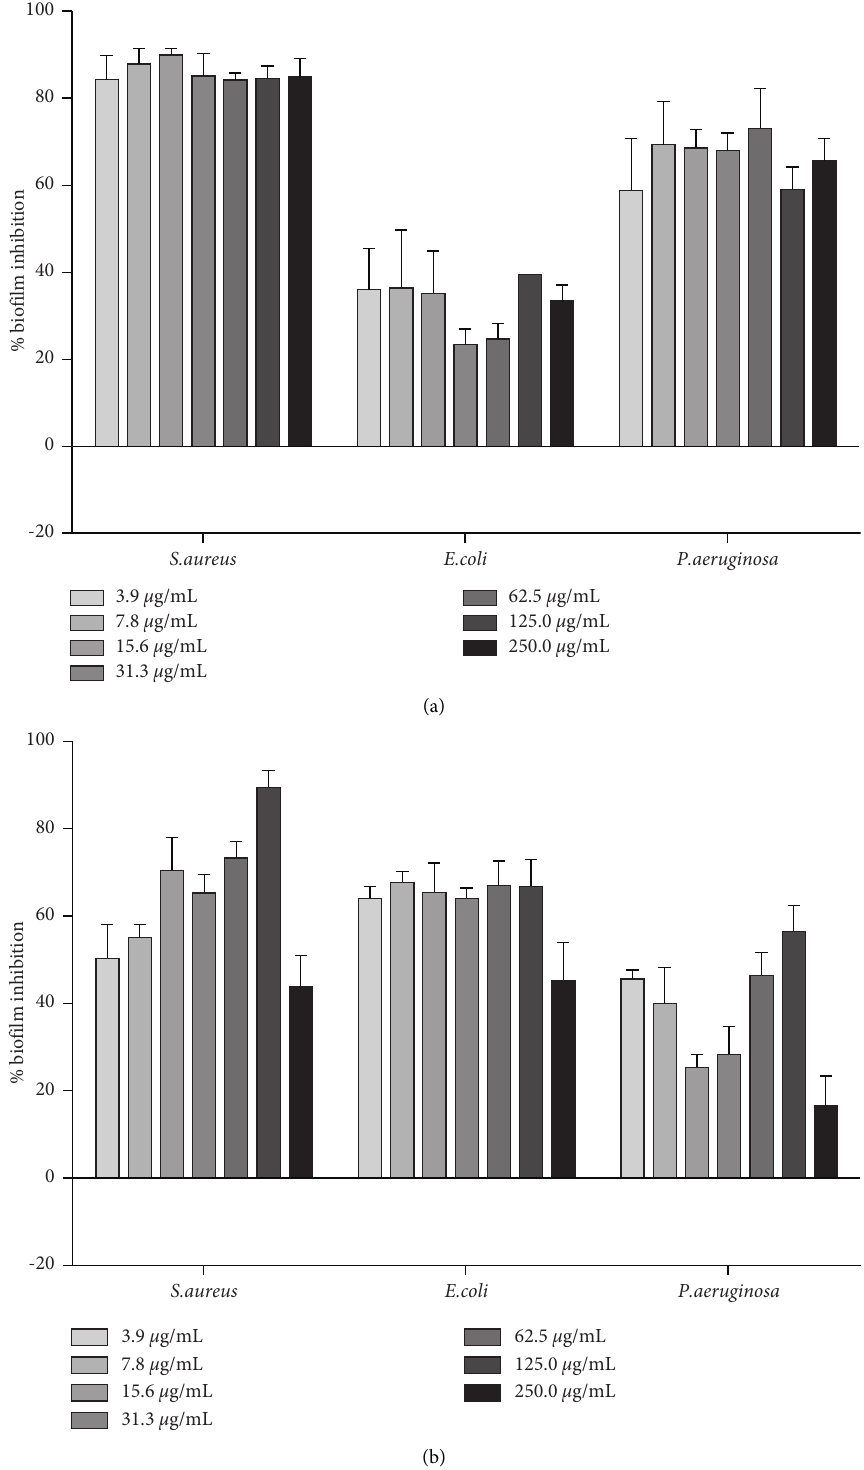
Figure 2: Antibiofilm formation activity of the EtOAc fraction, AEF (a), and the pet-ether fraction, APF (b), in S. aureus, E. coli , and P. aeruginosa